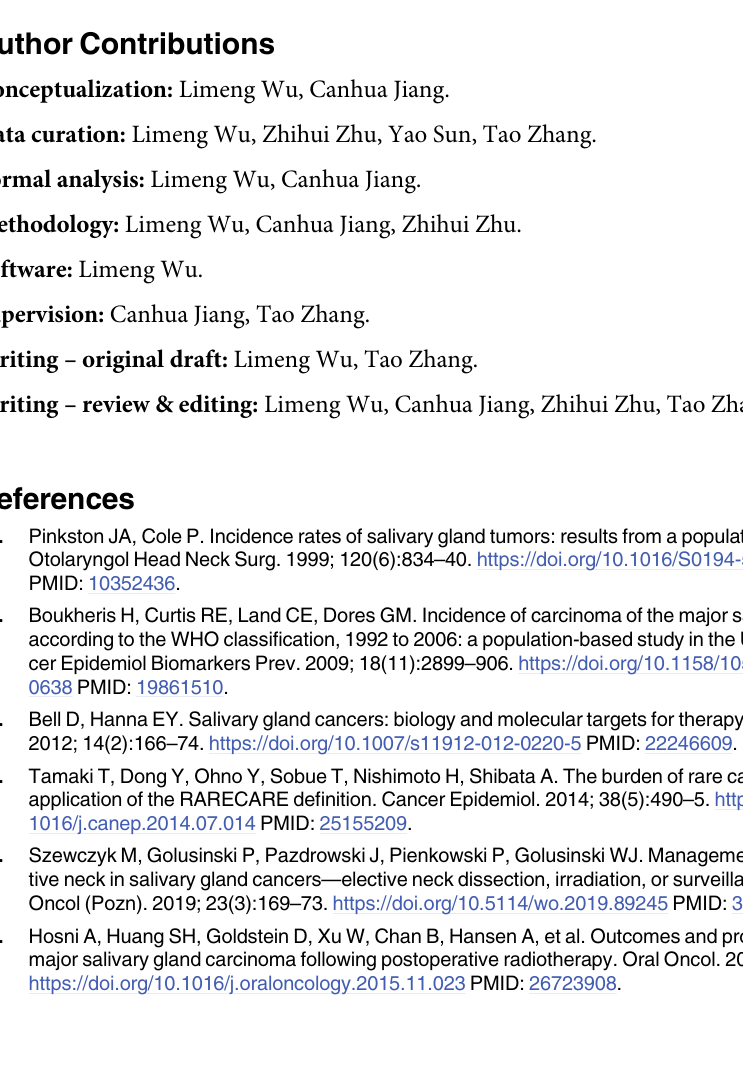
S1 Table. Search strategy of database. S2 Table. PRISMA checklist. S3 Table. Clinicopathological features of included studies. S4 Table. Survival parameters of included studies. S1 Fig. Sensitivity